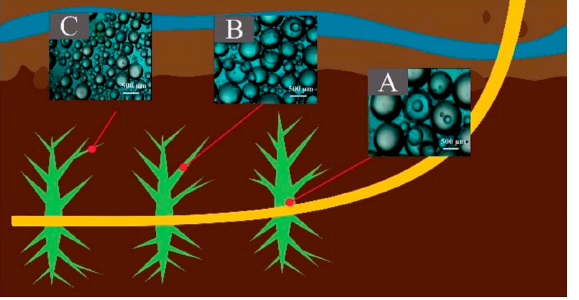
Figure 8. Hydraulic fracture propped with proppant of ( a ) large, ( b ) medium, ( c ) small size [9].